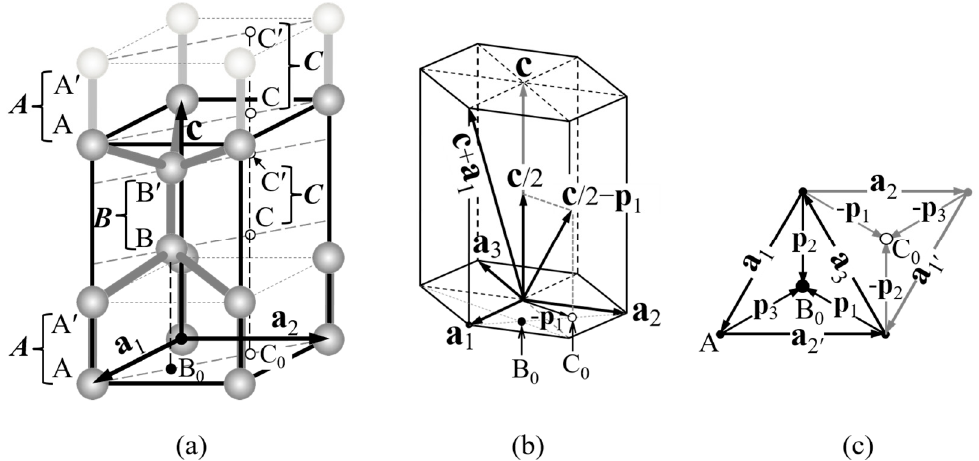
Figure 1. Burgers vectors in ice I h . ( a ) Oblique view of the ball-and-stick model [7] for the ice I h crystal structure, with the basis vectors a 1 , a 2 , and c forming a hexagonal unit cell (the lattice parameters a and c ). Balls (oxygen atoms) are connected by sticks (hydrogen bonds with one hydrogen per bond according to the ice rules [1,5,6]) to form the tetrahedral arrangement of water molecules. The sites B 0 and C 0 are the projections of the site B (and B ′ ) and the empty site C (and C ′ ) onto the basal plane on which a 1 and a 2 lie. Bimolecular layers A-A ′ , B-B ′ , and C-C ′ are designated bilayers A , B , and C , respectively. ( b ) Burgers vectors < c > , < a > , and < c + a > for perfect dislocations, and < p > , < c / 2 > , and < c / 2 + p > for partial dislocations. ( c ) Relations between the Burgers vectors < a > and < p > lying on the basal plane: a i = p j − p k ( i , j , k = 1, 2, 3 cyclic), with their magnitudes | a i | = a and | p i | = b p = a / √ 3.